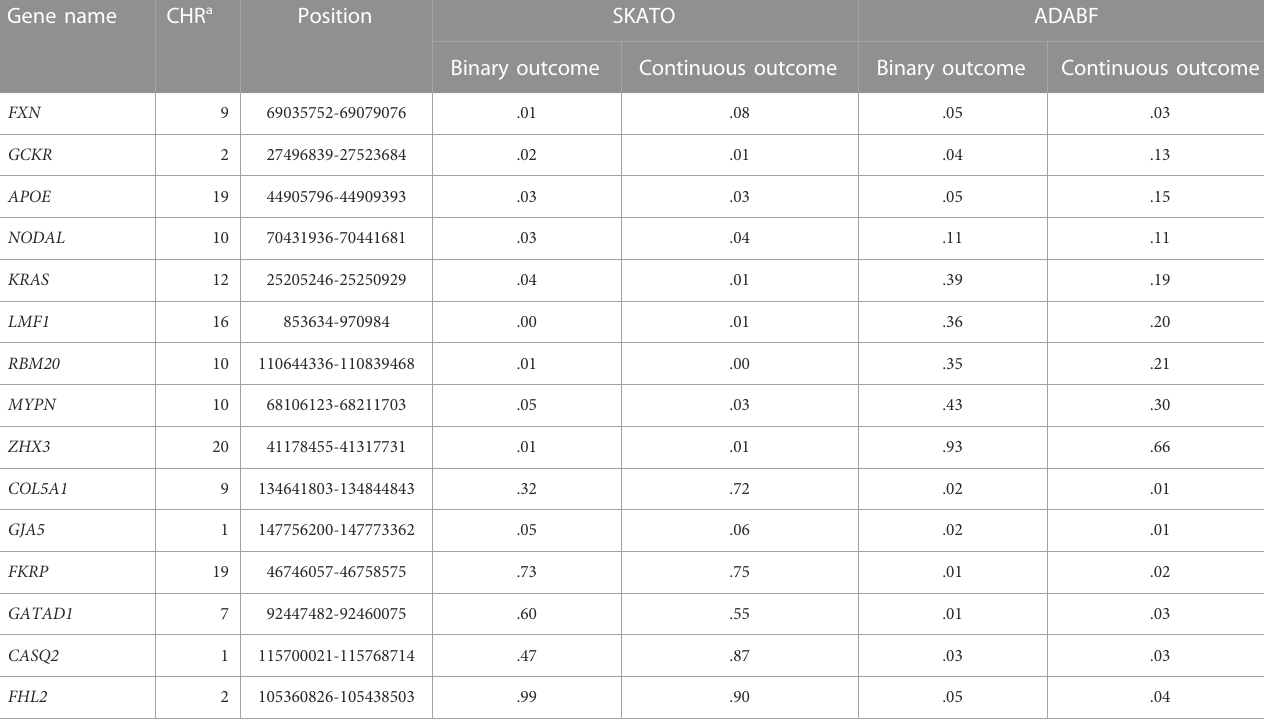
TABLE 3 Summarized signi fi cance level ( q -value of .05) for gene-based results according to the additive modes of inheritance. Gene name